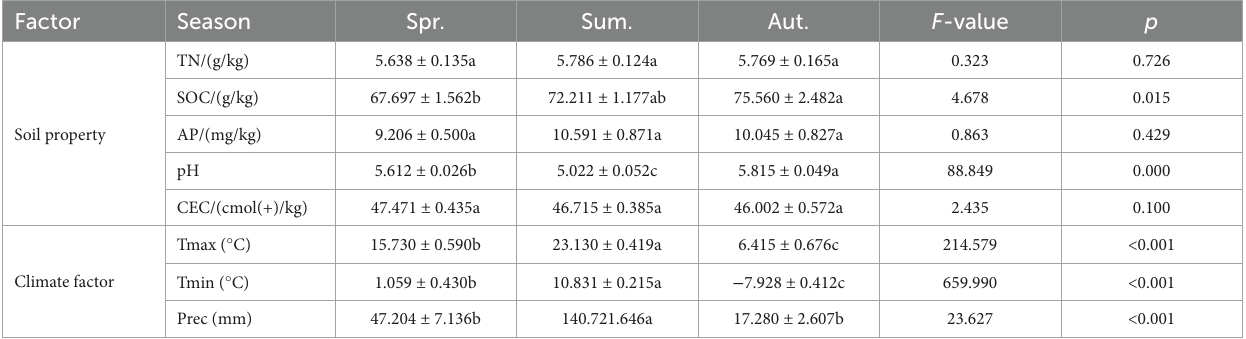
TABLE 1 Soil properties and climate factors compared by ANOVA (mean values ± S.E.s). Factor Spr.